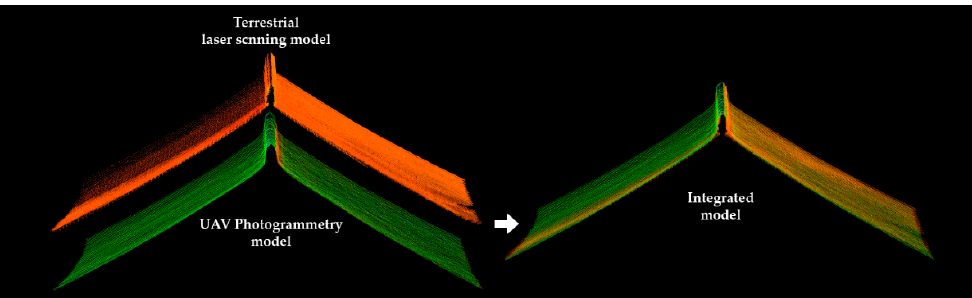
Figure 7. Graphs showing relative positional coordinate discrepancies between terrestrial laser scanning and UAV photogrammetry.